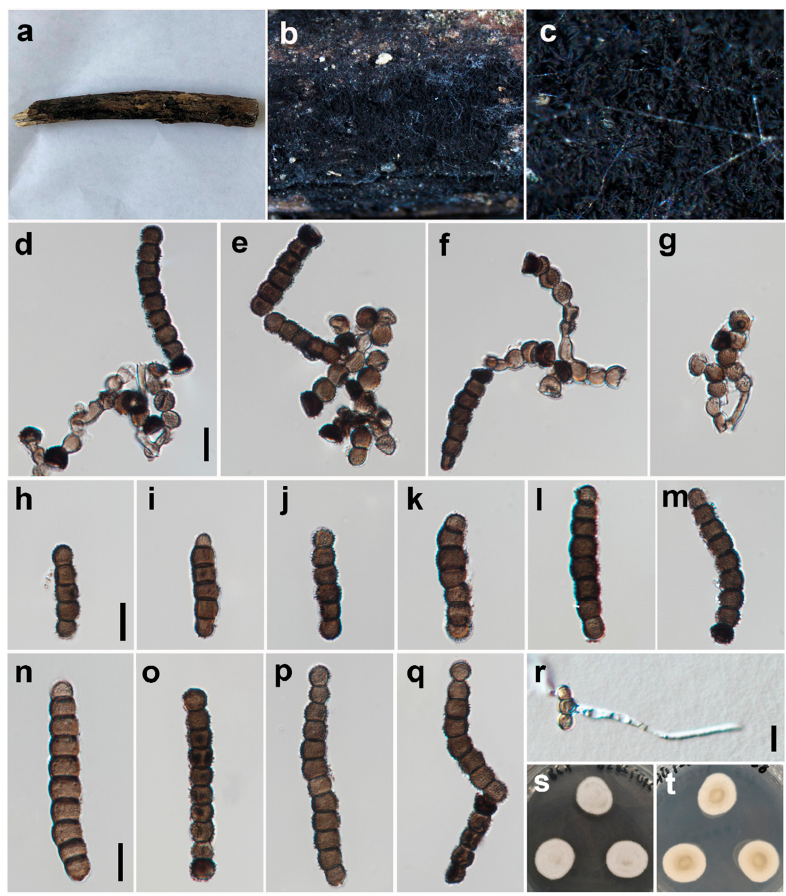
Figure 4. Torula masonii (HUEST 22.0090). ( a – c ) Colonies on the natural substrate. ( d – g ) Conidio- phores, conidiogenous cells and conidia. ( h – q ) Conidia; ( r ) Germinated conidium. ( s , t ) Culture on PDA from surface and reverse. Scale bars: ( d – r ) = 10 µ m. Scale bar of ( d ) applies to ( d – g ). Scale bar of ( h ) applies to ( h – m ). Scale bar of ( n ) applies to ( n – q